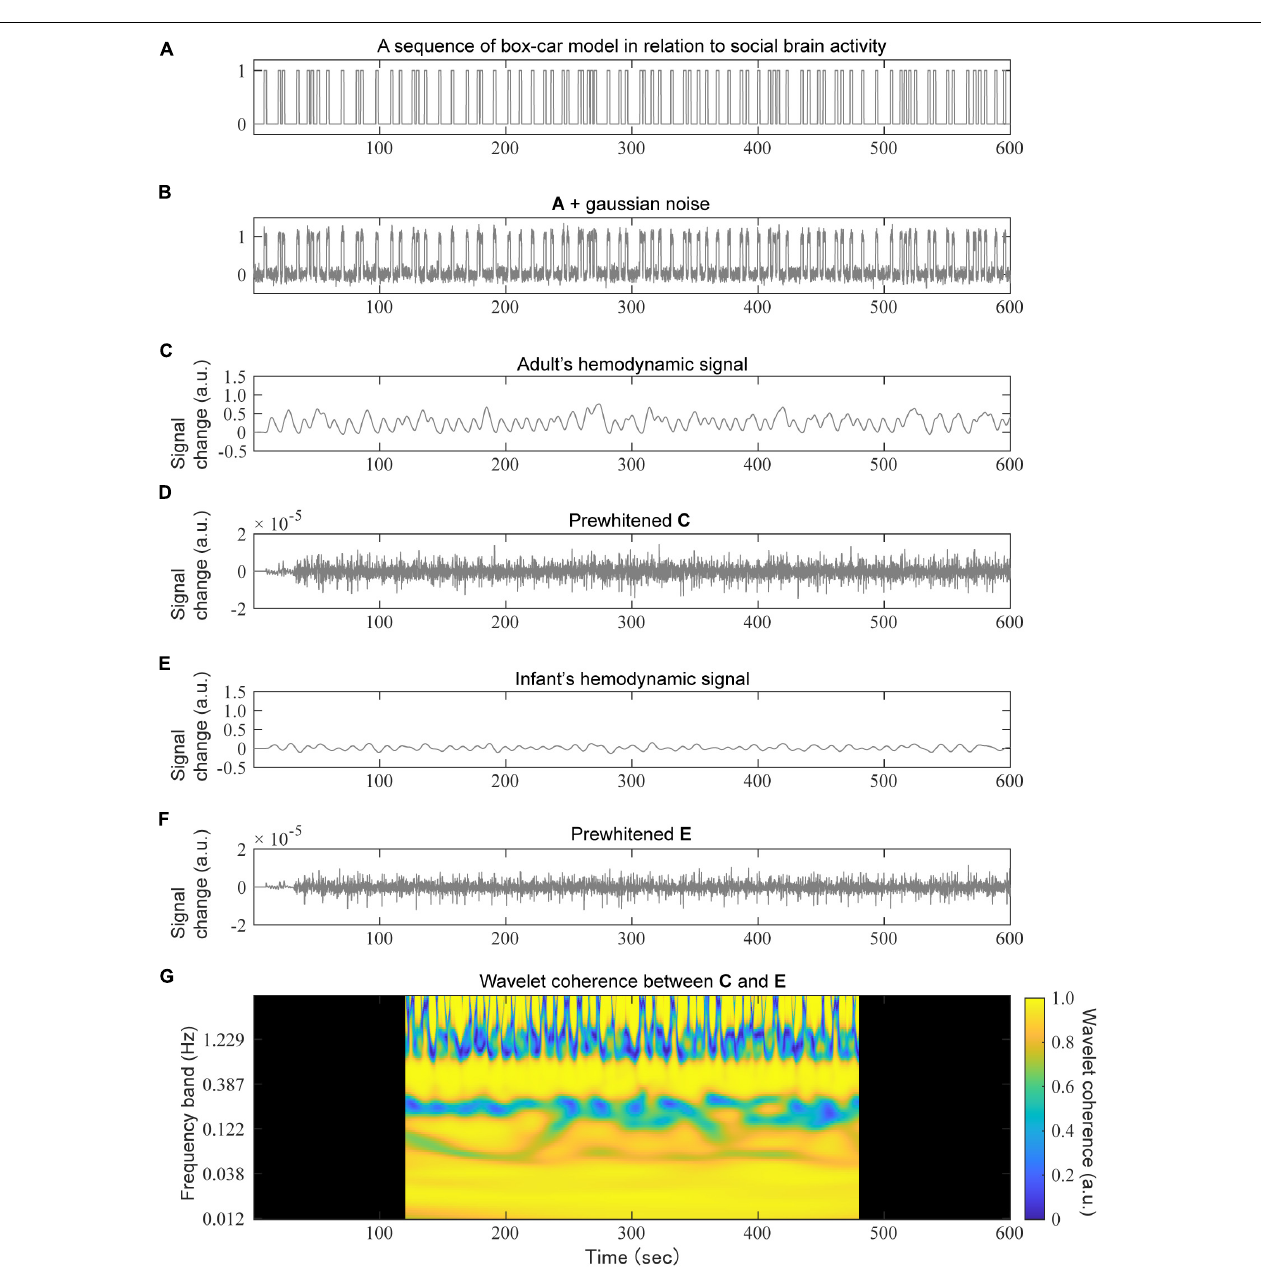
FIGURE 3 | An example of a simulation based on the social signal model. A randomly generated social event sequence with a box-car model (A) to which a small Gaussian noise was added (B) , convolved with the adult’s HRF (C) or infant’s HRF (E) to obtain a hemodynamic signal sequence. For the prewhitening test, an AR (100) filter was applied to the hemodynamic signals of both the adult (D) and infant (F) . Finally, the wavelet coherence between (D,F) was calculated (G) . The dark areas in panel (G) were removed for the subsequent mean